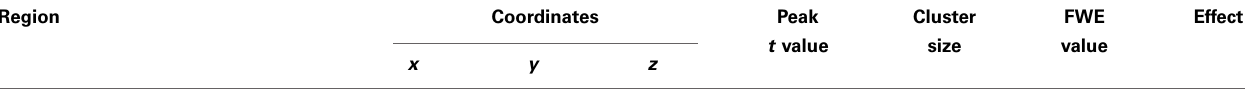
Table 3 | Effect of psychotherapy on hemodynamic responses—voxel-wise whole brain analysis.